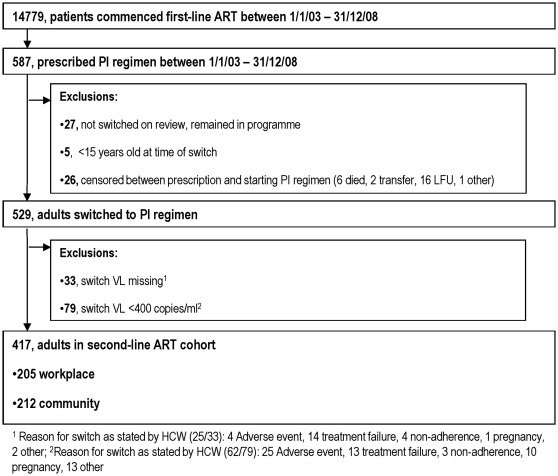
Study Flow diagram.Selection of adults for analysis, from a cohort of patients initiating first-line, NNRTI-based, ART between the 1st January 2003 and 31st December 2008.